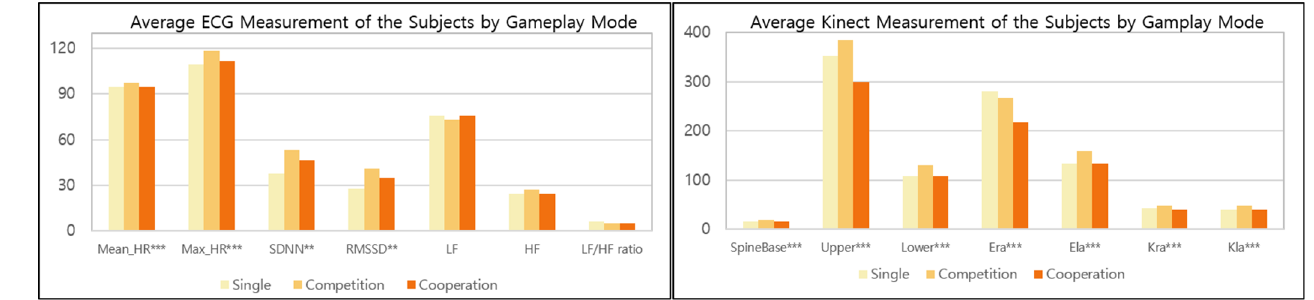
Figure 6. Average ECG and Kinect measurements of the subjects by gameplay mode (** p -value < 0.01 *** p -value < 0.001).